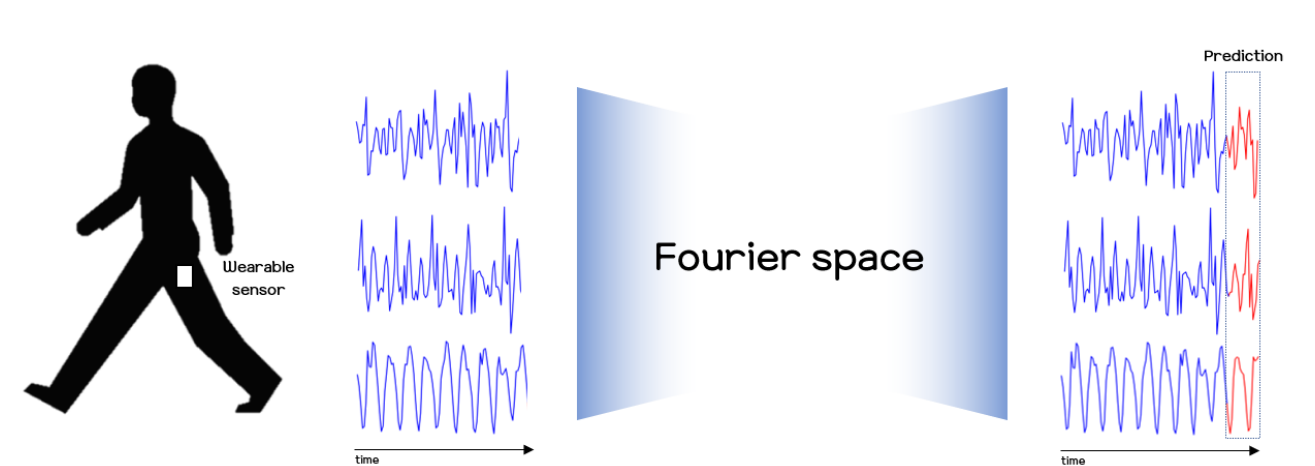
Figure 1. Overview of our proposed method for predicting human motion using wearable sensors and the modern deep learning